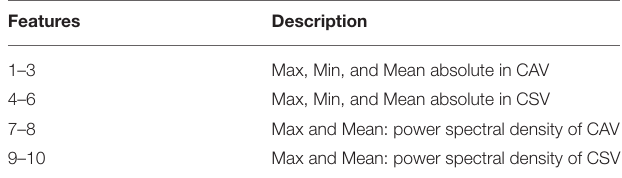
TABLE 1 | The time and frequency features in closed atrioventricular valve (CAV) and closed semilunar valve (CSV)